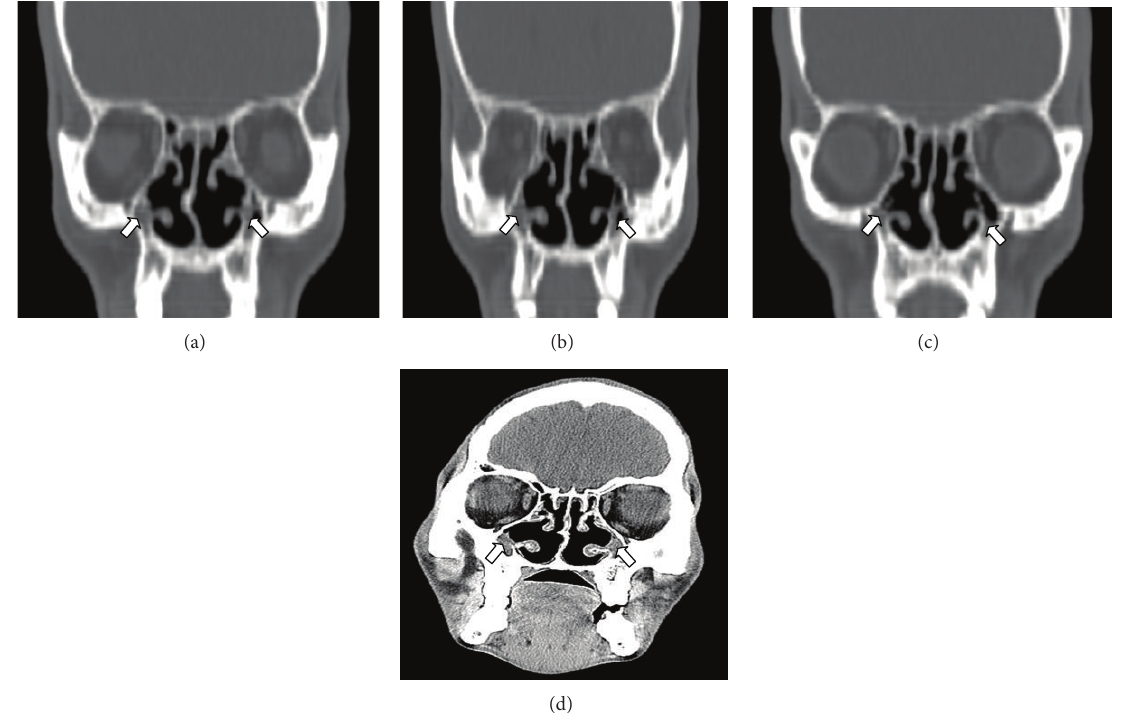
Figure 2: 25-year-old male with recurrent headache. Coronal sections plain CT paranasal sinuses showing cleft like bilateral maxillary sinuses with loss of pneumatisation